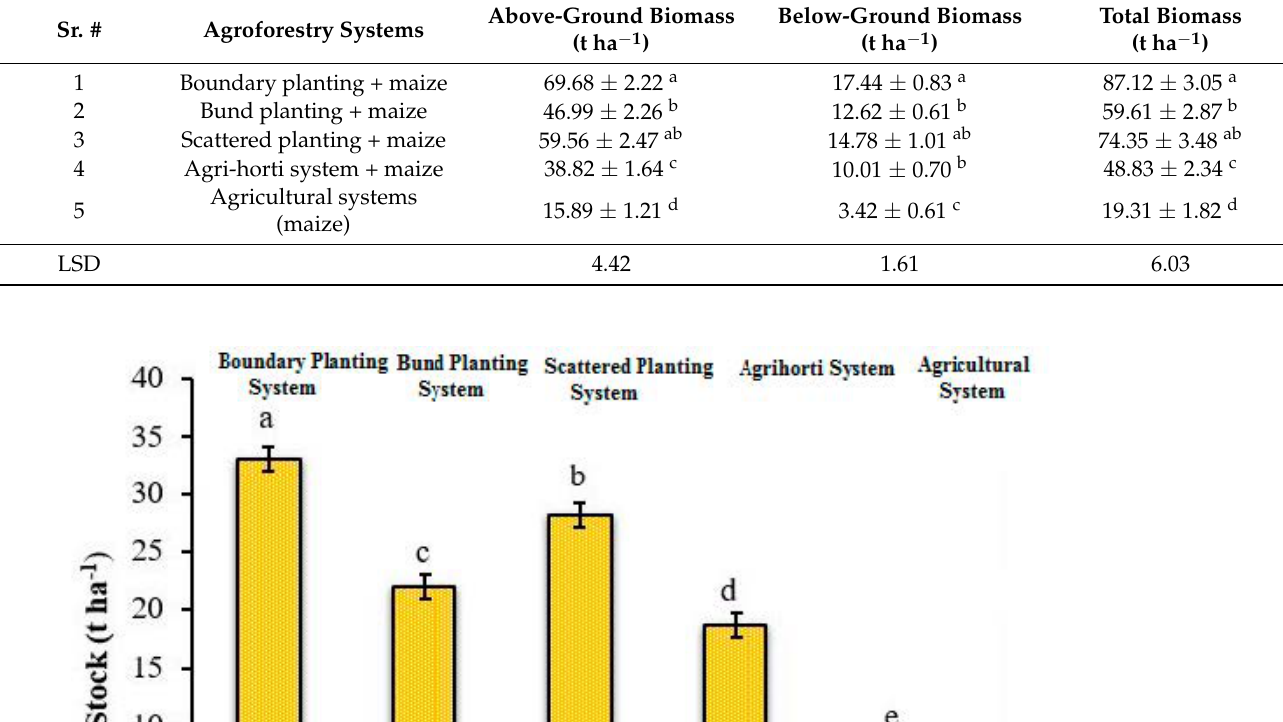
Table 3. Distribution of biomass (above, below, and total biomass) among different agroforestry systems in the semi-arid region.